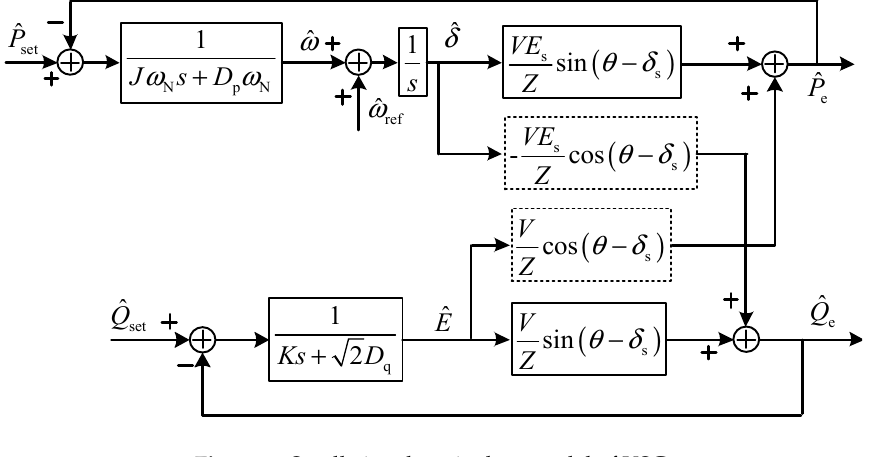
Figure 3. Small-signal equivalent model of VSG.